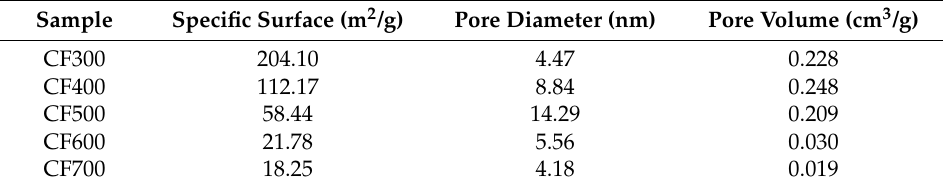
Table 1. Specific surface, pore diameter, and pore volume of synthesized CoFe 2 O 4 samples.